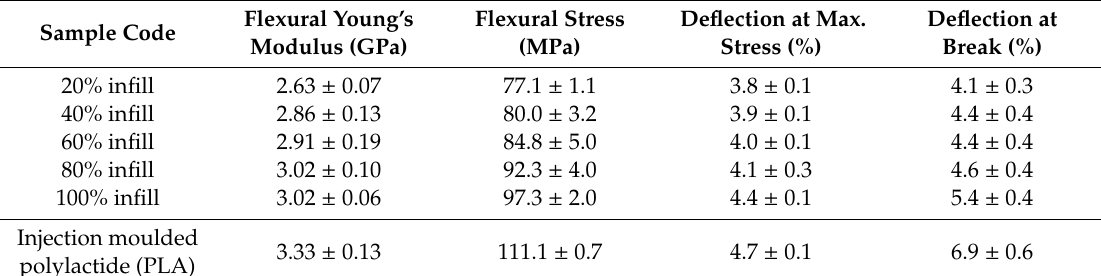
Table 2. Flexural properties of 3D-printed / injection moulded PLA specimens.